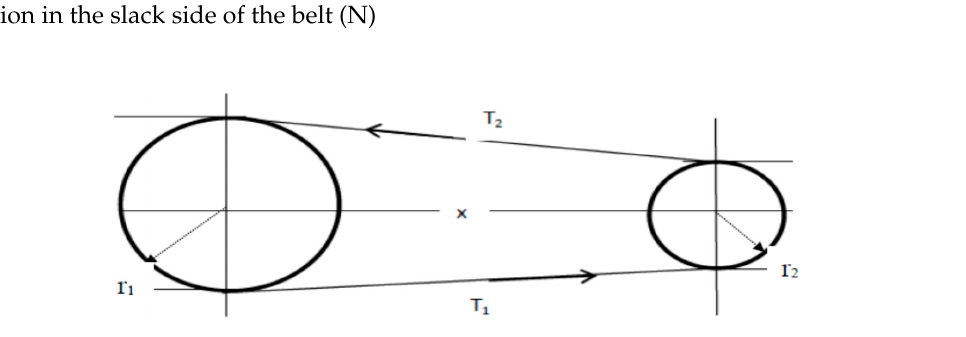
Figure 2. Design of length of belt.